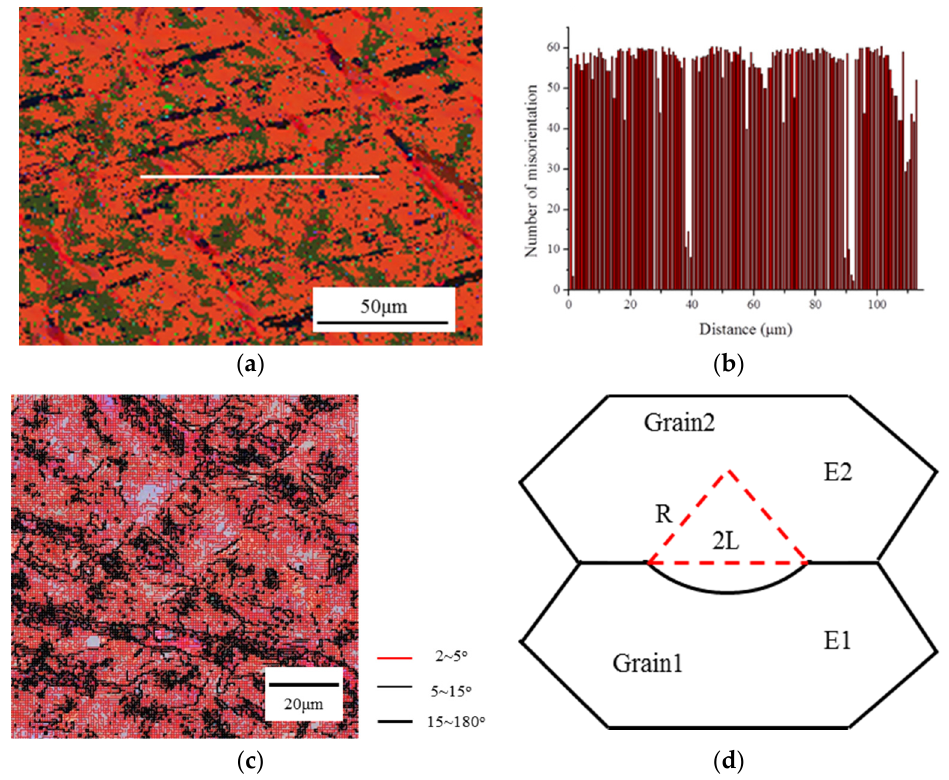
Figure 4. Rotary swaged microstructure with radial strain of 0.2 and semi-solid microstructure analyzed by electron backscatter diffraction (EBSD): ( a ) rotary swaged C5191 alloy orientation map [21], ( b ) misorientation distribution map corresponding to the line in (a) [21], ( c ) map of low-angle grain boundaries of rotary swaged C5191 alloy, and ( d ) strain induced grain boundary migration of a boundary separating a grain of low stored energy (E2) from one of higher energy (E1) adapted from [17].